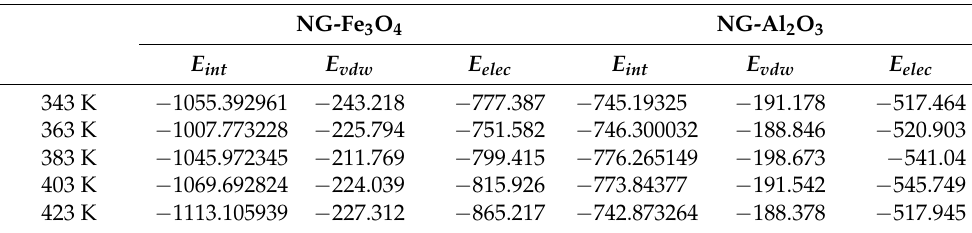
Table 2. Interaction energy between metal oxide and insulating oil molecules at different temperatures